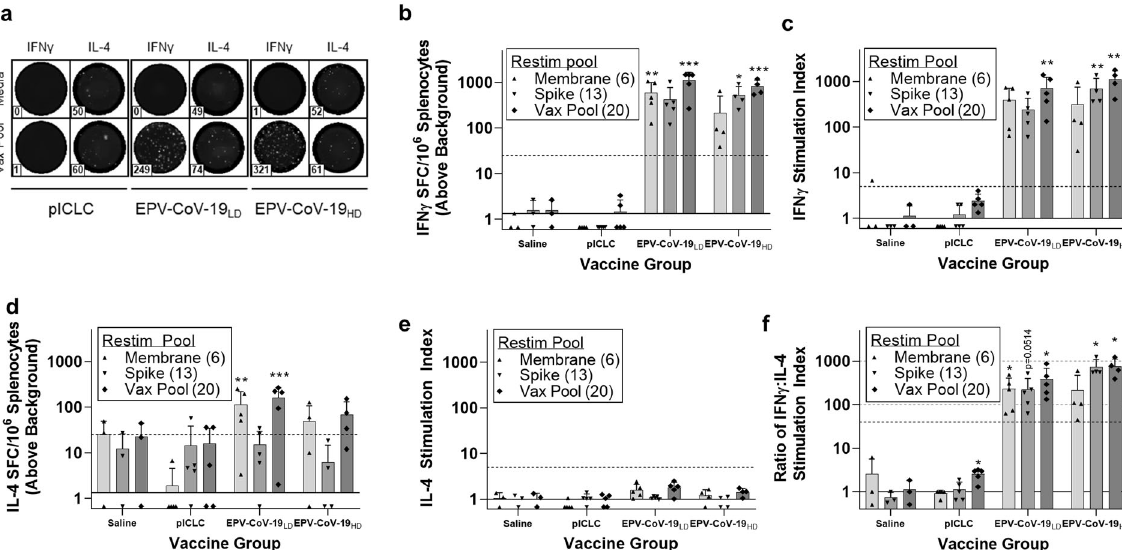
Fig. 4 EPV-CoV-19 immunization stimulates strong type 1-skewed T-cell responses in HLA-DR3 transgenic mice. Eight days post boost, murine splenocytes were isolated and assayed for epitope-speci fi c recall responses. Cells were plated in dual IFN γ /IL-4 Fluorospot plates and restimulated with peptide pools for 48 h. a Representative images and spot counts are shown for both cytokines ( n = 3). b IFN γ SFC counts were normalized to 1 × 10 6 cells and adjusted by background subtraction, and c IFN γ SI index was determined by calculating the fold change of individual restimulation replicates over background. d IL-4 SFC and e SI were similarly calculated. Dotted horizontal lines denote positivity criteria of SFC > 25 and SI > 5, respectively. Solid horizontal lines denote threshold of detection for assay. f From the reported IFN γ and IL-4 stimulation indexes, we calculated the IFN γ : IL-4 ratio of each restimulation replicate to model the overall skewing of the immune response, identifying a sharply type 1 skewed phenotype in all vaccinated animals. Dotted horizontal lines identify 40, 100, and 1000-fold skewing of type 1/type 2 response. Solid horizontal line identi fi es hypothetical balanced response (Th1 = Th2). Error bars depict SD. Saline n = 3, pICLC n = 5,